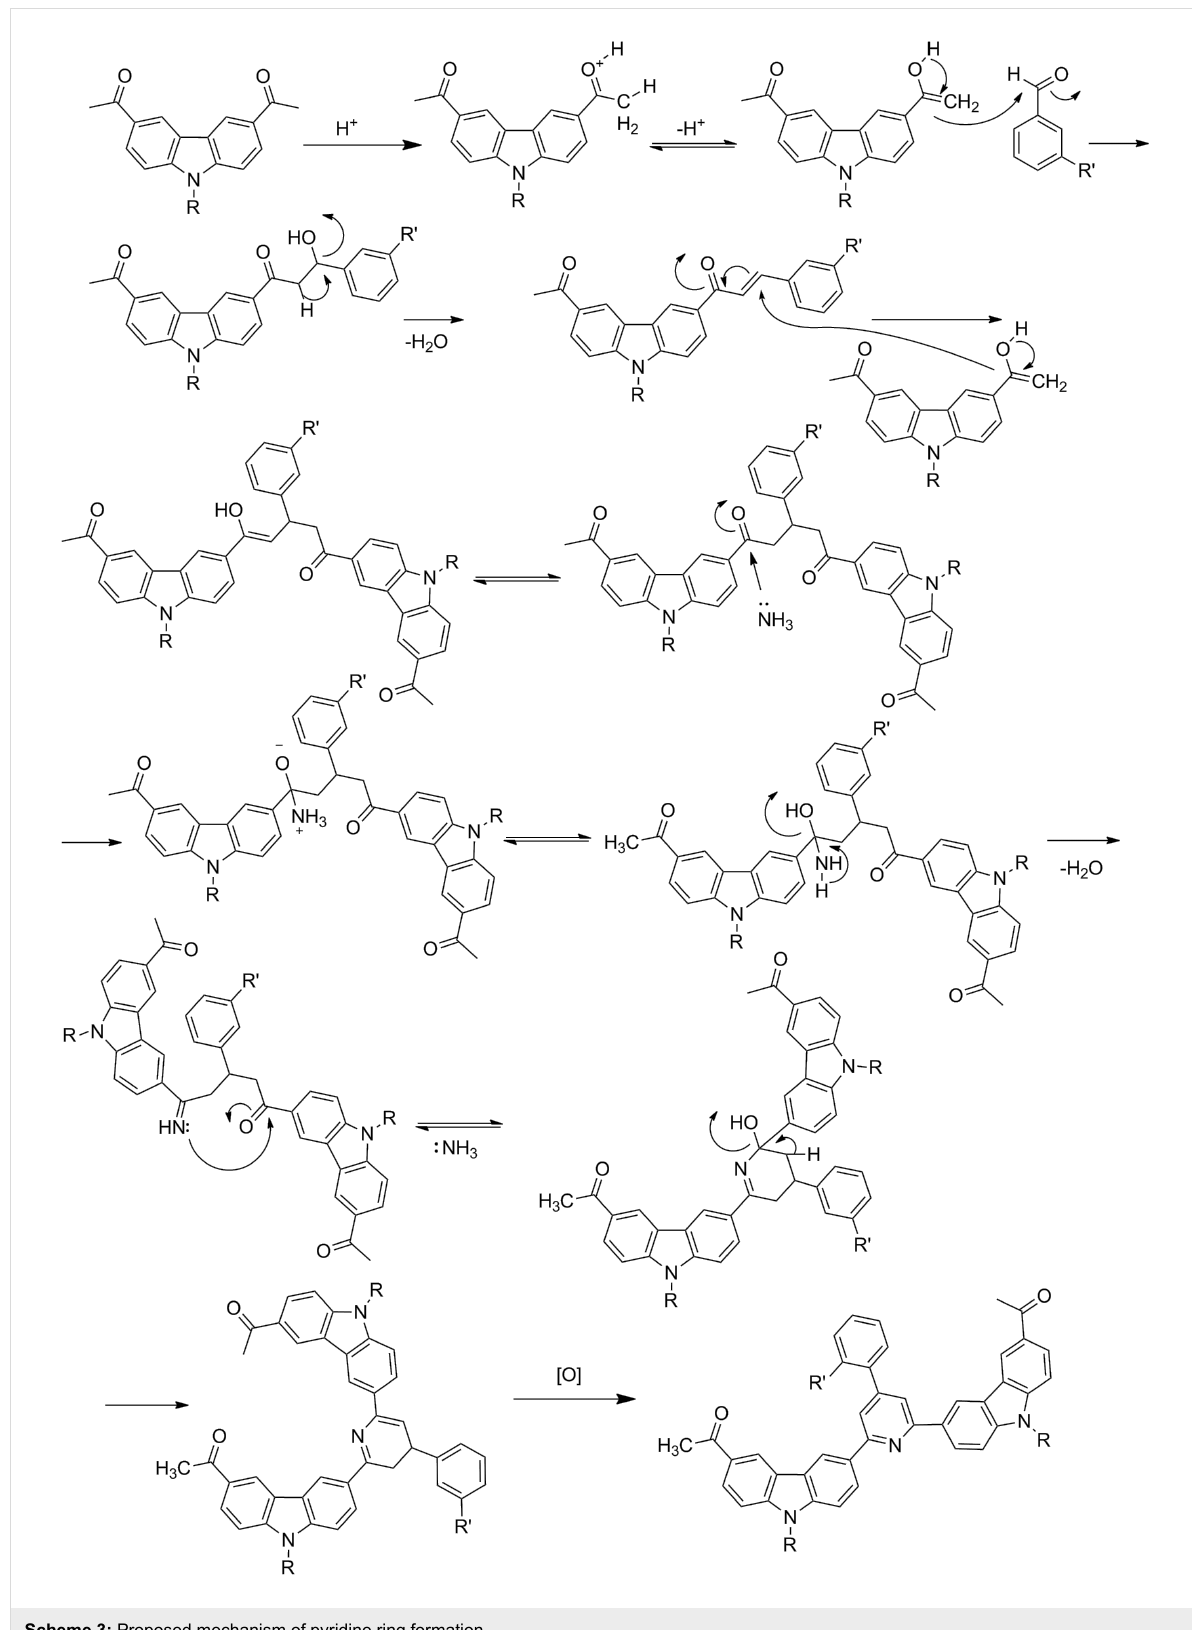
Scheme 3: Proposed mechanism of pyridine ring